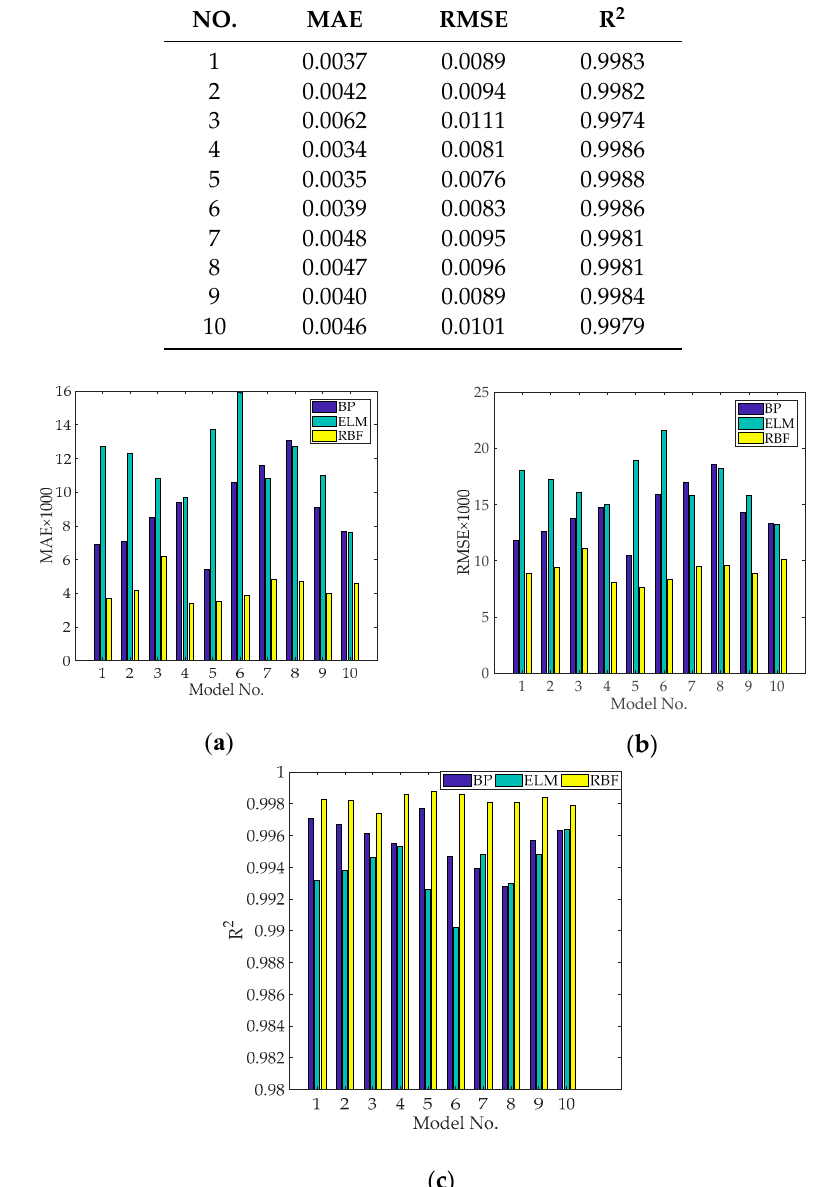
Figure 2. Performance indexes of the validation set: ( a ) Mean absolute error (MAE); ( b ) Root mean square error (RMSE); ( c ) R 2 . Table 4. Performance index data of back propagation neural network (BPNN) sub–models (Validation set).